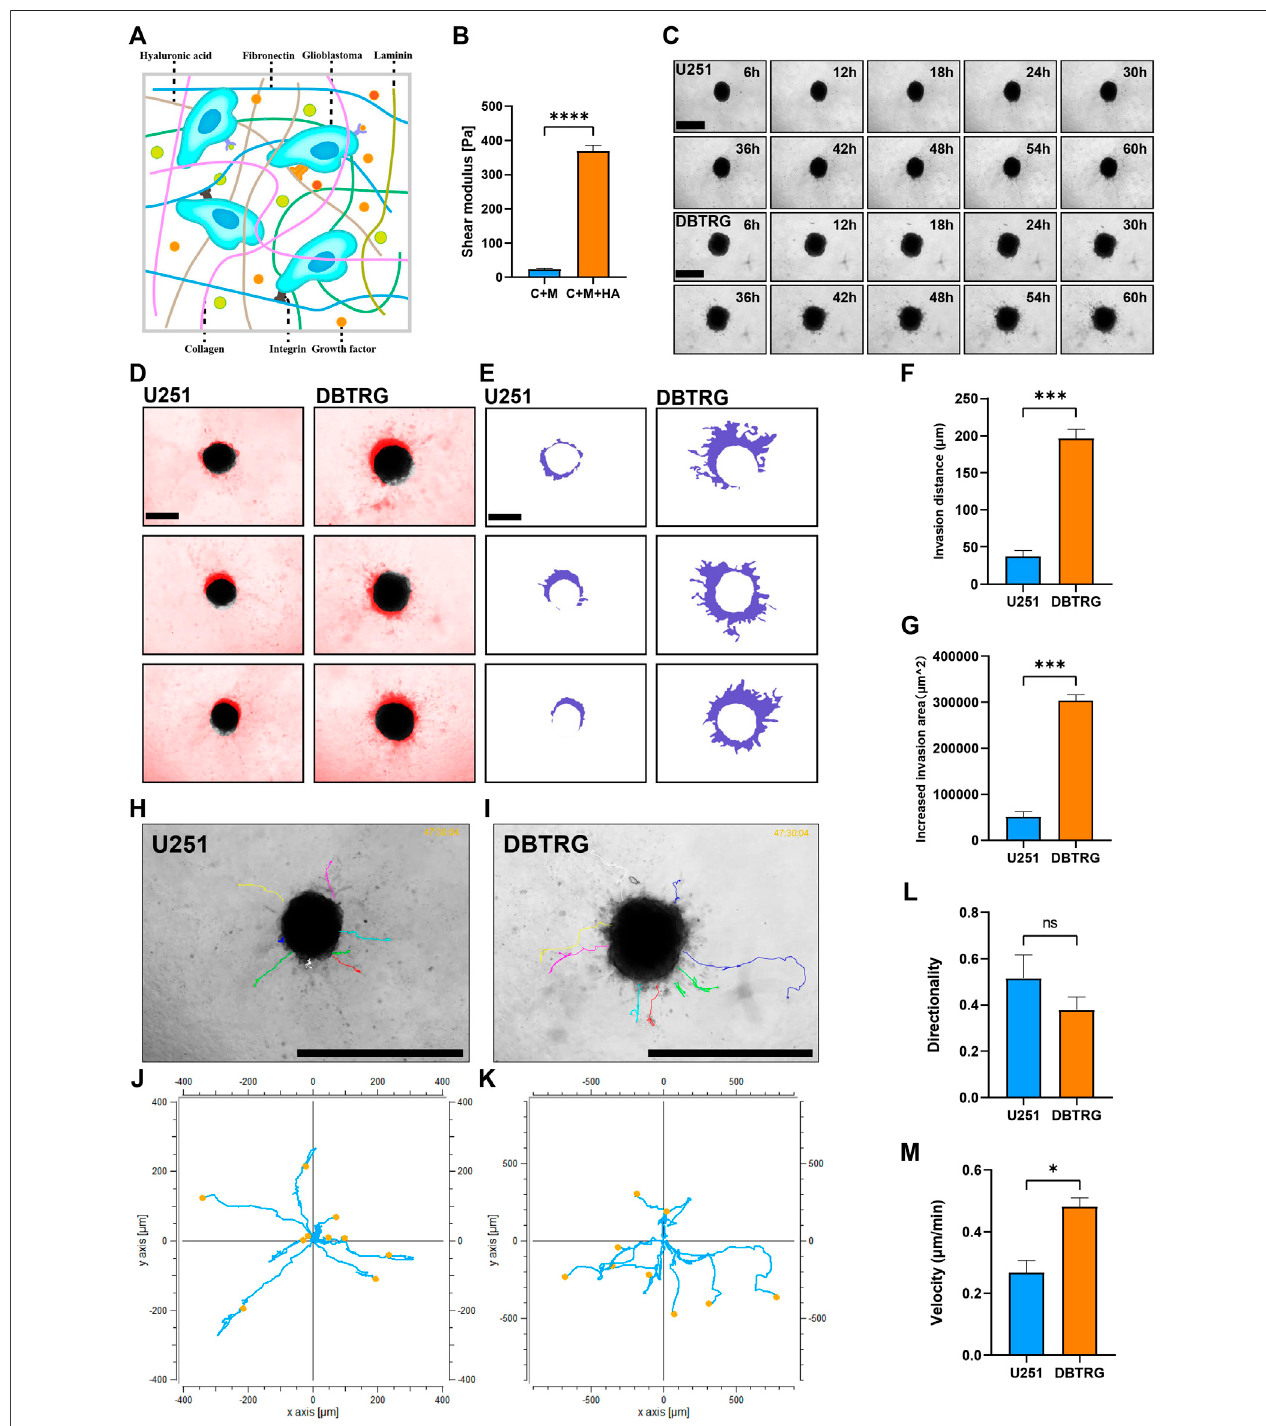
FIGURE 3 | Quantitative invasion analysis of DBTRG and U251 spheroid in 0.5 mg/ml Collagen Ⅰ + 3 mg/ml Matrigel +3.3 mg/ml HA. (A) Schematic shows the matrixproteinsenrichedinthebrainmicroenvironment. (B) Theshearelasticmodulusofthematrixgelincreasedfrom23.04±2.84 Pato367.91±17.43 Paafteradding hyaluronicacidtothematrixgelofCollagen Ⅰ +Matrigel. (C) RepresentativeimagesofU251andDBTRGspheroidsin0.5 mg/mlCollagen Ⅰ +3 mg/mlMatrigel+3.3 mg/ ml HAwithin 60 h. Scalebar = 600 µm. (D) Invasion ofU251 and DBTRG tumor multicellular spheroids in0.5 mg/ml Collagen Ⅰ +3 mg/ml Matrigel +3.3 mg/ml HA within 60 h. The black color is the distribution of the tumor multicellular spheroid at 0 h, and the red color indicates the distribution of the tumor multicellular spheroid at 60 h minus that of 0 h. Scale bar = 400 µm. (E) Invasion area (purple area) of U251 and DBTRG spheroids within 60 h in 0.5 mg/ml Collagen Ⅰ + 3 mg/ml Matrigel